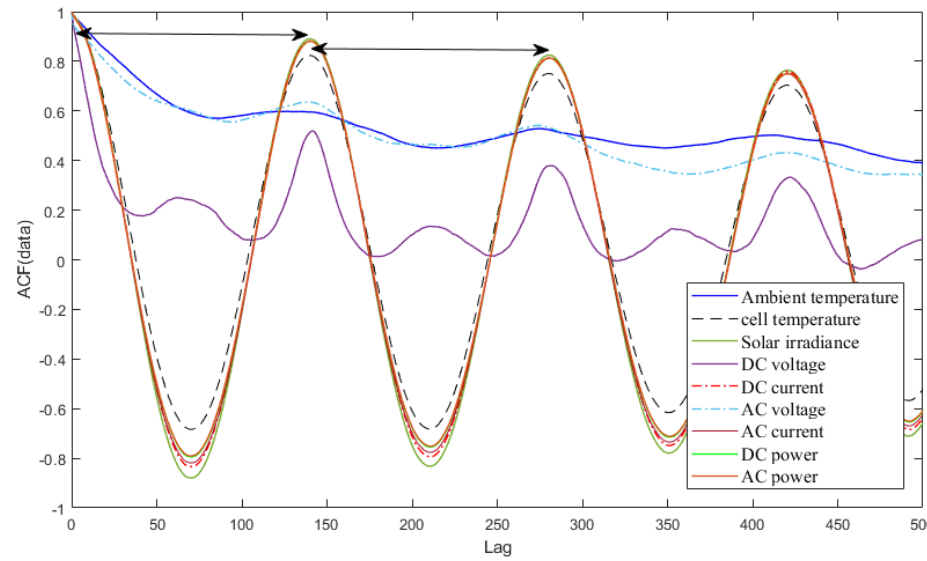
Figure 5. Sample ACF of the training data.